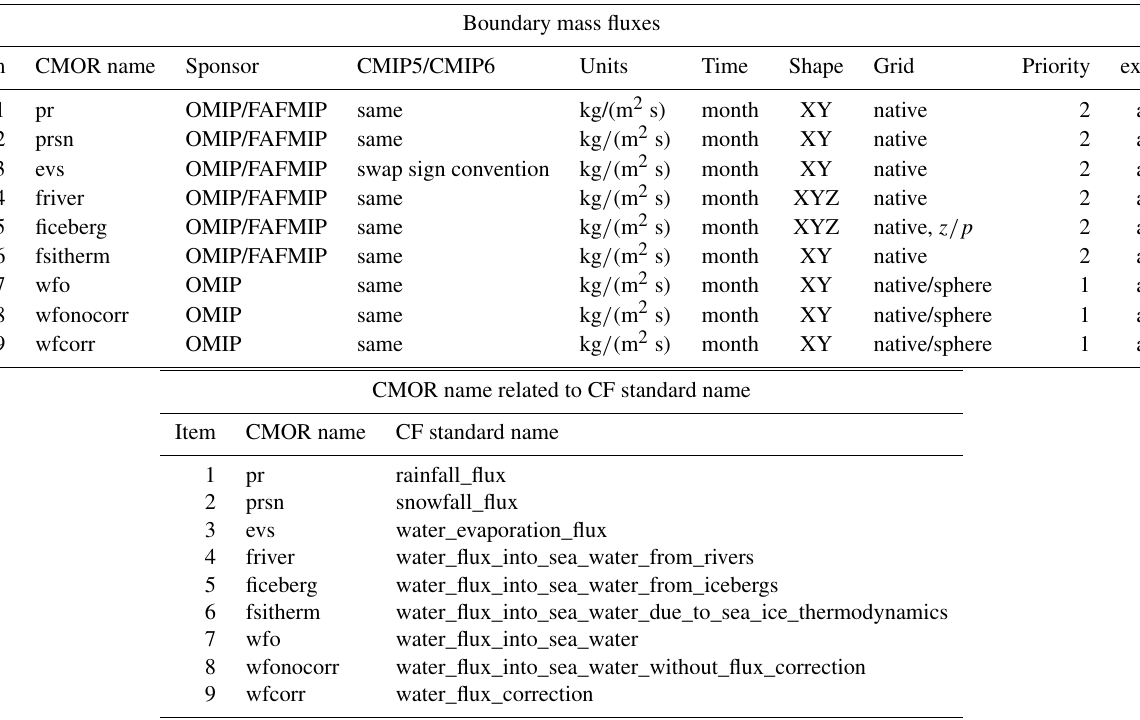
Table K1. This table details the boundary fluxes of water mass to be saved from the ocean model component in CMIP6 simulations. Positive fluxes are into the ocean. Hence, for example, evaporating water represents a negative mass flux (this sign convention is opposite that for CMIP5). The column indicating the experiment for saving the diagnostics generally says “all”, in which case we recommend the diagnostic be saved for CMIP6 experiments in which there is an ocean model component, including the DECK, historical simulations, FAFMIP, DAMIP, DCPP, ScenarioMIP, and C4MIP, as well as the ocean/sea-ice OMIP simulations. The Priority = 1 diagnostics should be saved as decadal time means at decadal intervals for the piControl spin-up. Entries with grids denoted “native/sphere” denote diagnostics where native and spherical output are recommended to facilitate analysis (see the discussion in Sect. A3). The bottom sub-table lists the relation between the CMOR name for a diagnostic and its CF standard